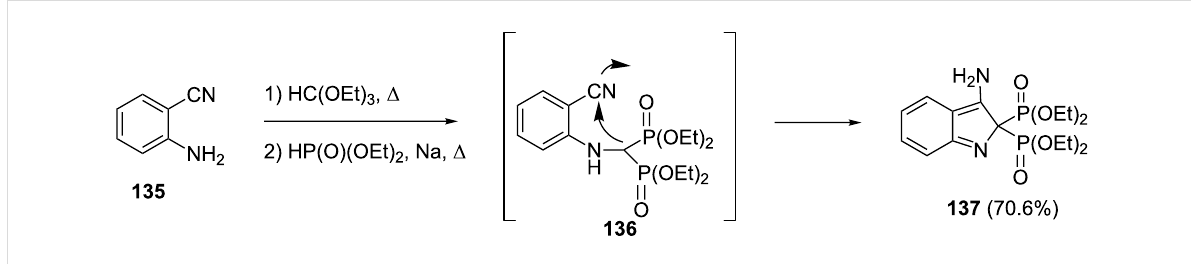
Scheme 29: Synthesis of indole bisphosphonates through a modified Kabachnik–Fields